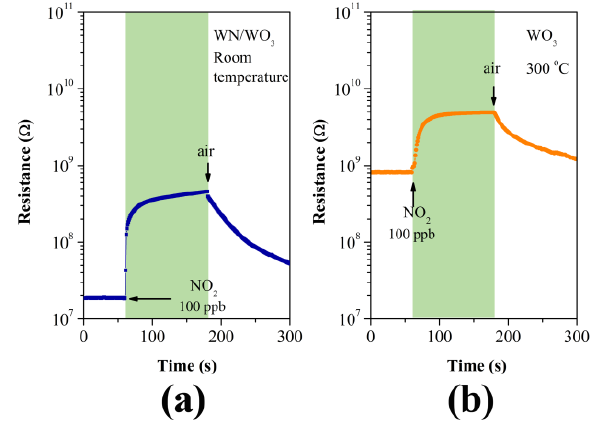
Figure 6. Dynamic sensing transients to 100 ppb NO 2 of ( a ) WN/WO 3 composite nanosheets sensors at room temperature; and ( b ) WO 3 nanosheets sensors at 300 °C.